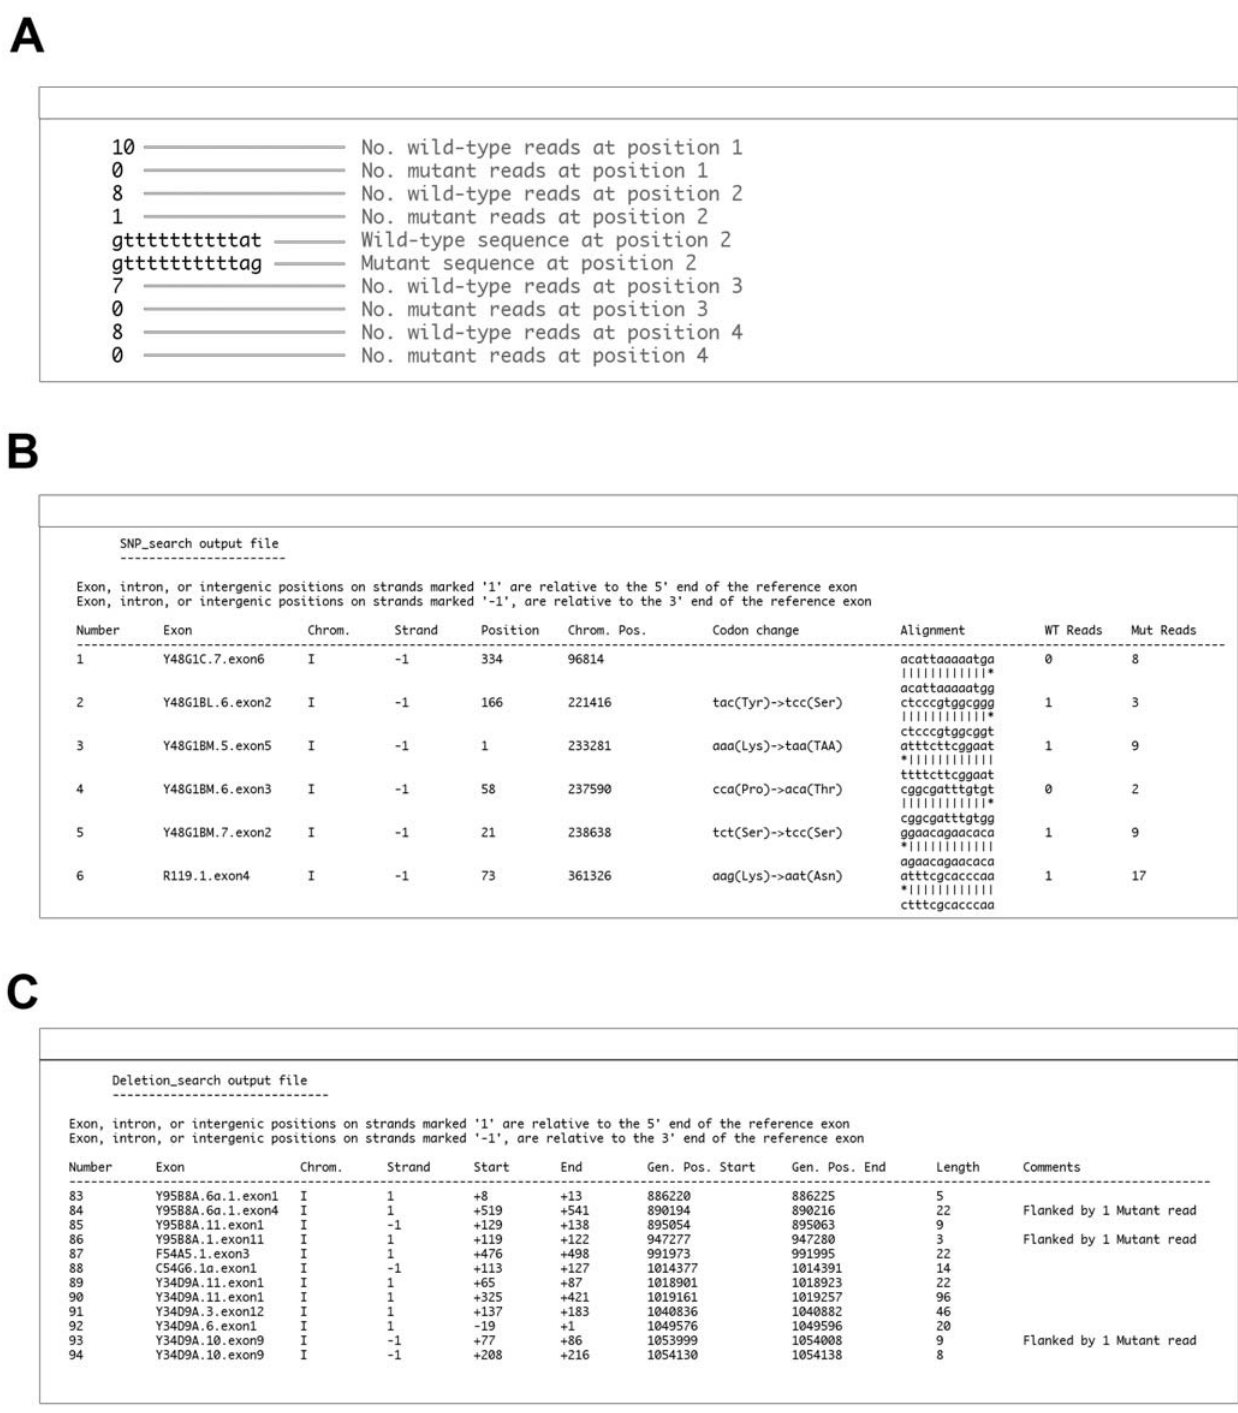
Figure 2. ‘galign’ output files. (A) A portion of a ‘galign’ alignment tool output file indicating the numbers of wild-type and mutant reads at a given position, as well as the corresponding wild-type and mutant sequences displayed in the event that a mutation was detected. (B) A portion of a SNP_search output file is depicted for a search involving exonic sequence substitutions. Position, position with respect to exon start site. Chrom. Pos., position with respect to the indicated chromosome. WT reads, number of wild-type reads at the given position. Mut reads, number of mutant reads at the given position. (C) A portion of a Deletion_search outputfile is depicted for a search involving deletions spanning exons. Start, End, the start and end coordinates of the deletion with respect to the first nucleotide of the indicated exon. Gen. Pos. Start, Gen. Pos. End, start and end coordinates of deletion with respect to the indicated chromosome. The Comments column is used to highlight features indicative of true deletions and insertions.